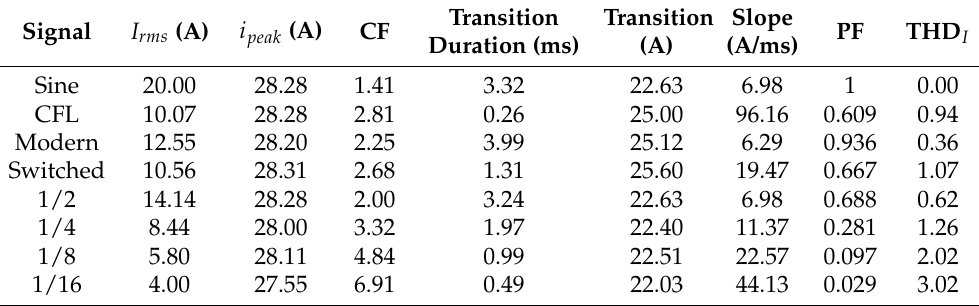
Table 1. Tests waveforms parameters.